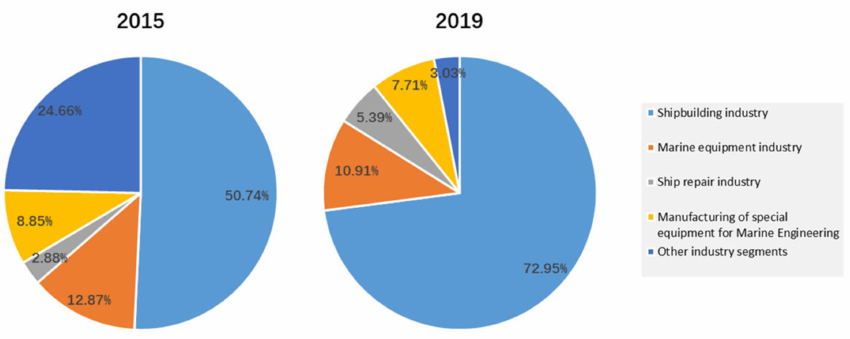
Figure 1. Comparison of shipbuilding industry structure based on the share of business